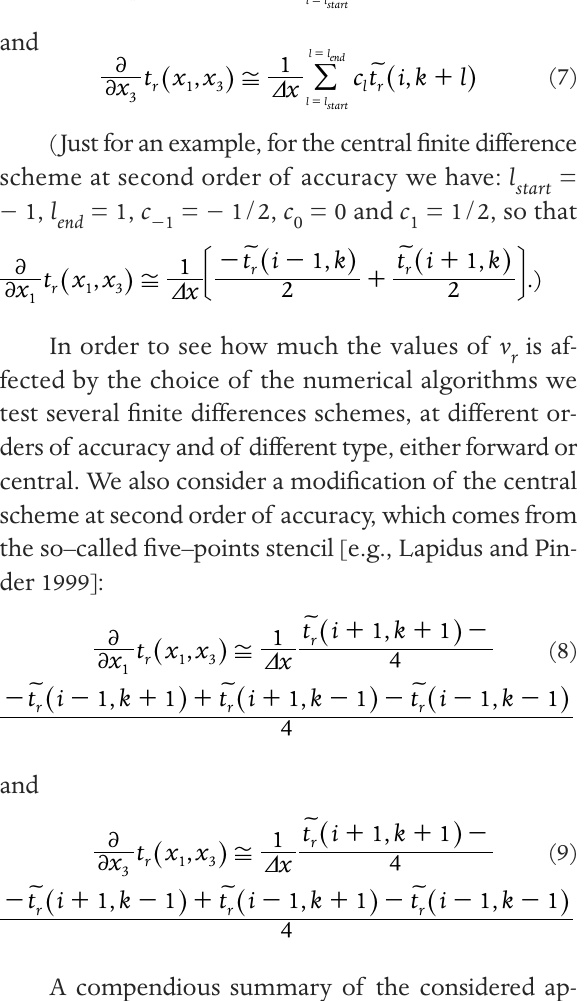
Table 2. Different numerical schemes used to discretize Equation (1). The various multiplier coefficients { c reported. For each type of approximation the first and the last non null coefficients determine l